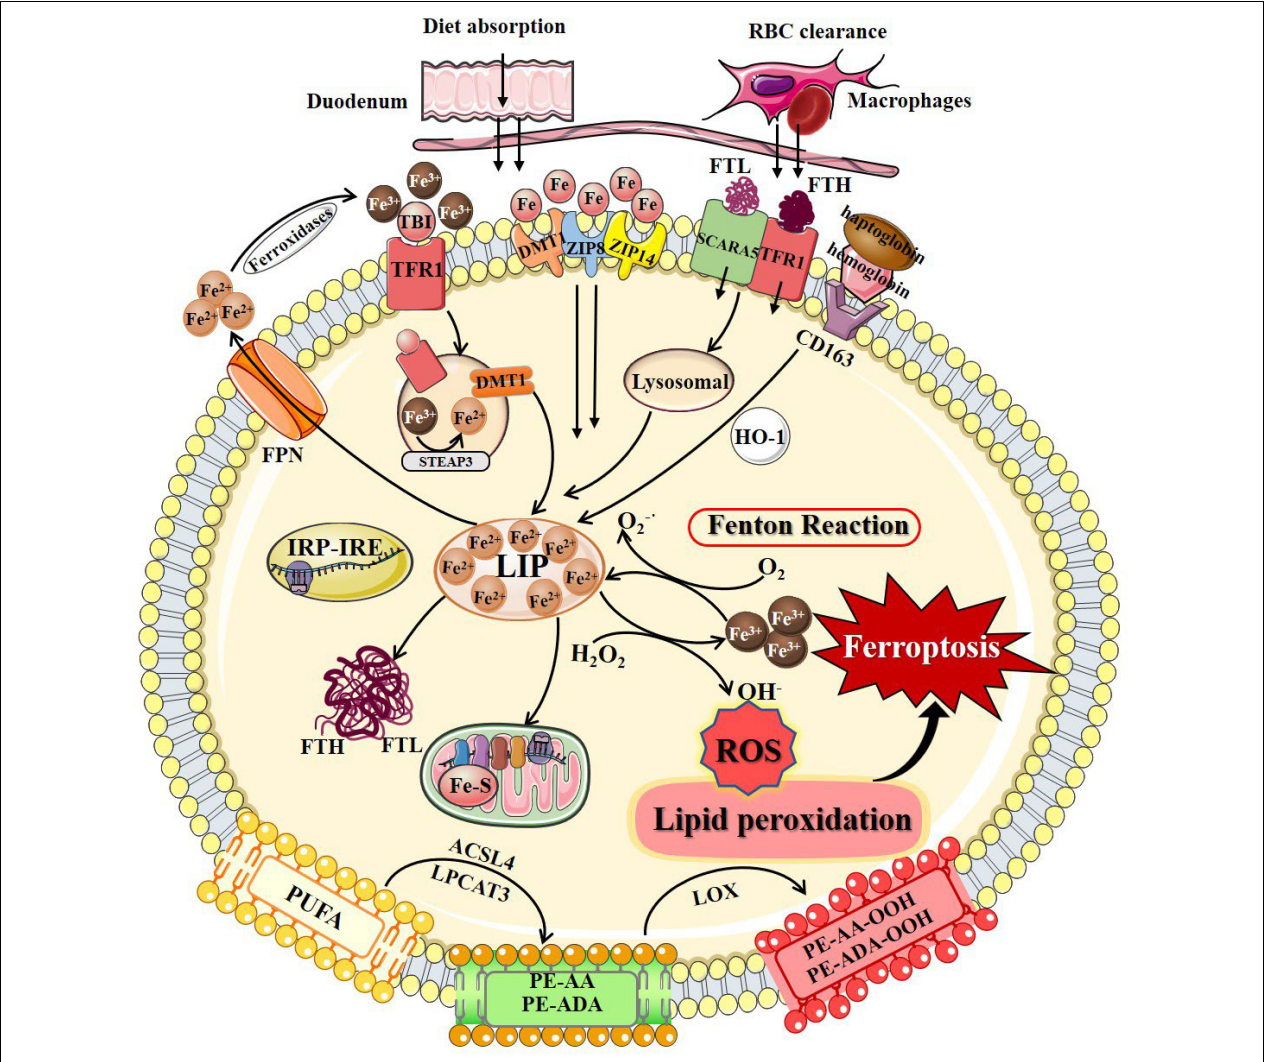
FIGURE 1 | The process of ferroptosis. The occurrence of ferroptosis depends on the intracellular iron deposition caused by the disorder of iron metabolism. The body iron intake takes place by tissue macrophage-dependent aging red blood cells engulfing and duodenal enterocytes-mediated diet absorption into the bloodstream. Cellular iron absorption involves the following pathways: transferrin-bound iron pathway, non-transferrin bound iron pathway, SCARA5/TfR1-dependent endocytosis, and hemoglobin-dependent pathway. Intracellular Fe 2 + formed LIP, stored in FTL and FTH in the cytosol, or as Fe–S in the mitochondrial respiratory chain. IRP/IRE regulates iron homeostasis by regulating the transcription of iron metabolism genes. When cellular iron metabolism is disordered, accumulated intracellular Fe 2 + undergo Fenton’s reaction with H 2 O 2 to generate OH · . OH · and other ROS attack the PUFAs on the membrane surface to cause membrane peroxidation and release oxidative toxic substances such as 4-HNE and MDA. Consequently, membrane structure, proteins, and genetic materials are damaged, which affects organelles’ functions and cell homeostasis, causing ferroptosis at last. 4-HNE, 4-hydroxynonenal; ACSL4, long-chain-fatty-acid-CoA ligase 4; DMT1, divalent metal transporters 1; FPN, ferroportin; Fe–S, iron-sulfur clusters; FTH, ferritin heavy chain; FTL, ferritin light chain; HO-1, heme oxygenase 1; IRP/IRE, iron-regulatory protein/iron-responsive element; LIP, labile iron pool; LPCAT3, lysophosphatidylcholine acyltransferase 3; LOX, lipoxygenase; MDA, malondialdehyde; PUFAs, polyunsaturated fatty acids; PE-AA, phosphatidylethanolamines-arachidonoyl; PE-AA-OOH, hydroperoxides of phosphatidylethanolamines-arachidonoyl; PE-ADA, phosphatidylethanolamines-adrenoyl; PE-ADA-OOH, hydroperoxides of phosphatidylethanolamines- adrenoyl; ROS, reactive oxygen species; SCARA5, scavenger receptor class A member 5; TfR1, transferrin receptor 1; ZIP8, Zrt/Irt-related protein 8; ZIP14, Zrt/Irt-related protein